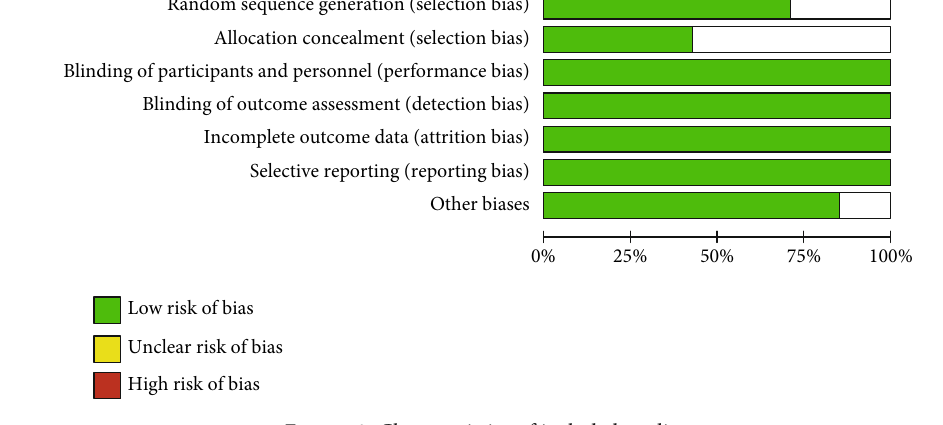
Mean difference IV. random, 95% Cl